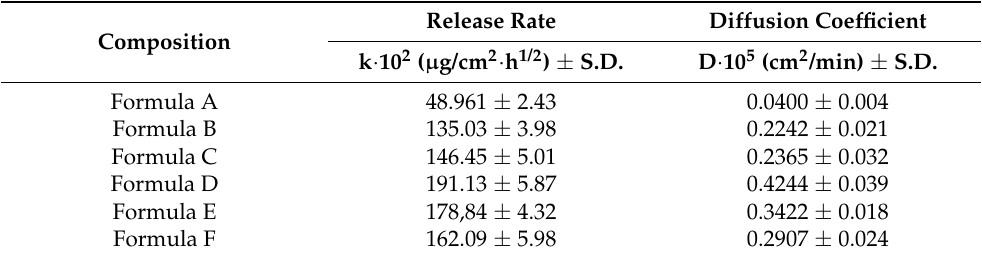
Table 7. Quercetin release rate and the diffusion coefficient values related to the formulations A-F. Each data point represents the mean ± S.D., n = 6.